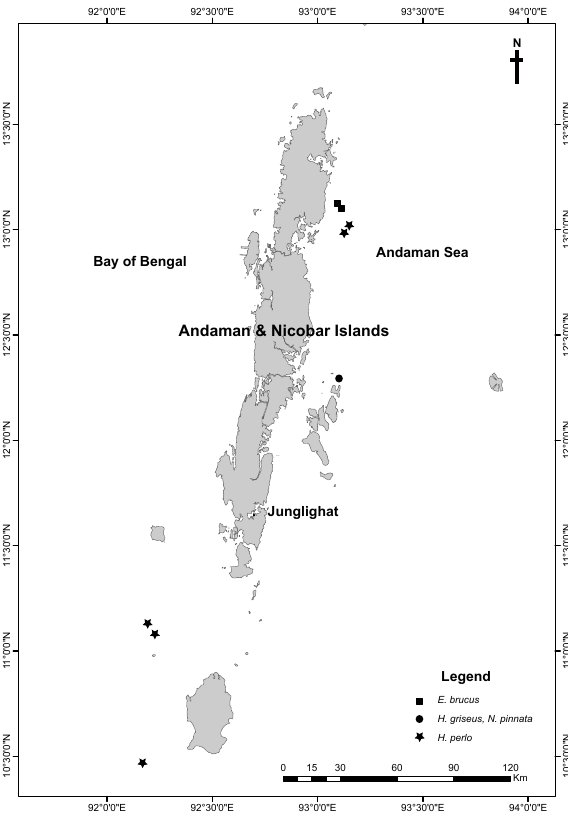
Fig. 1. Map showing collection sites of chondrichthyans ( Heptranchias perlo , Hexanchus griseus , Echinorhinus brucus , Neoharriotta pinnata ) from Andaman waters,